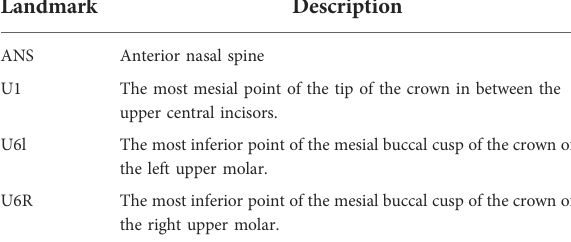
TABLE 1 Reference landmarks description. TABLE 2 Differences between the two groups in angular deviations of the vector and linear deviations of the distractor